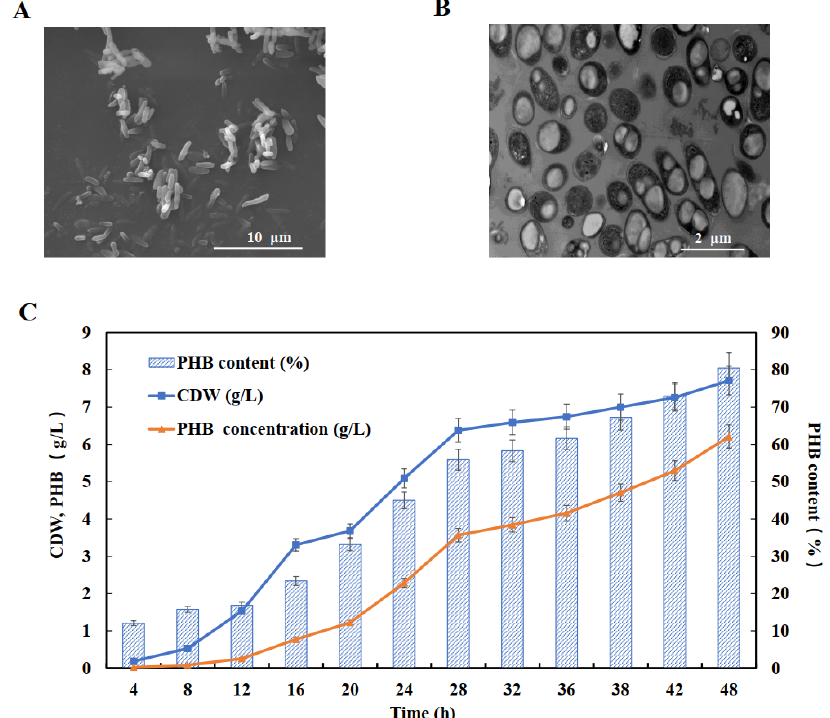
Figure 4. Bacterial growth and PHB production by E. coli SAPL harboring plasmids pBHR-P 3nirB , pMCS- sacC under anaerobic conditions. ( A ) SEM micrographs of recombination strain; ( B ) TEM micrographs of recombination strain; ( C ) CDW, PHB concentration, and PHB content